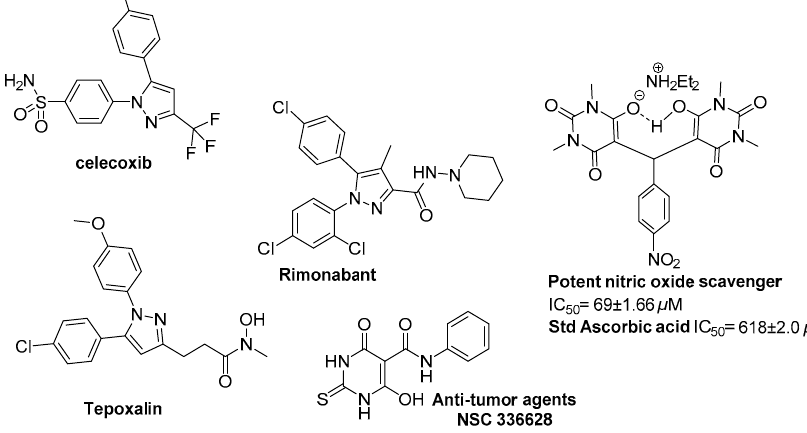
Figure 1. Biologically active pyrazole and barbituric acid scaffolds.